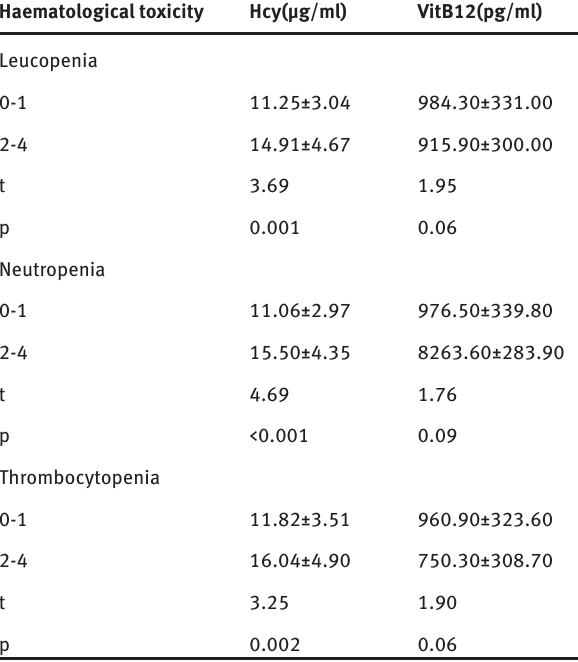
Table 3: Serum Hcy and VitB12 concentrations for each haematological toxicity